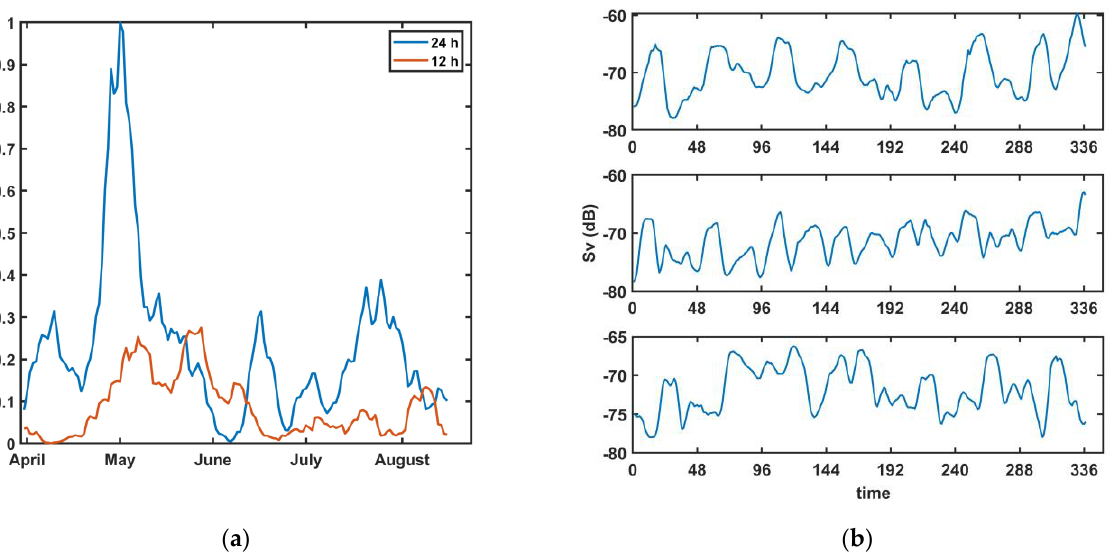
Figure 3. ( a ) Normalized time series of relative FFT amplitude of 24-h and 12-h at 24 m depth from ADCP measurements at W1-M3A observatory; ( b ) three subsamples of 7 days of acoustic data indicating the prevalence of daily (upper), twilight (middle) and mixed (lower) migration pattern.